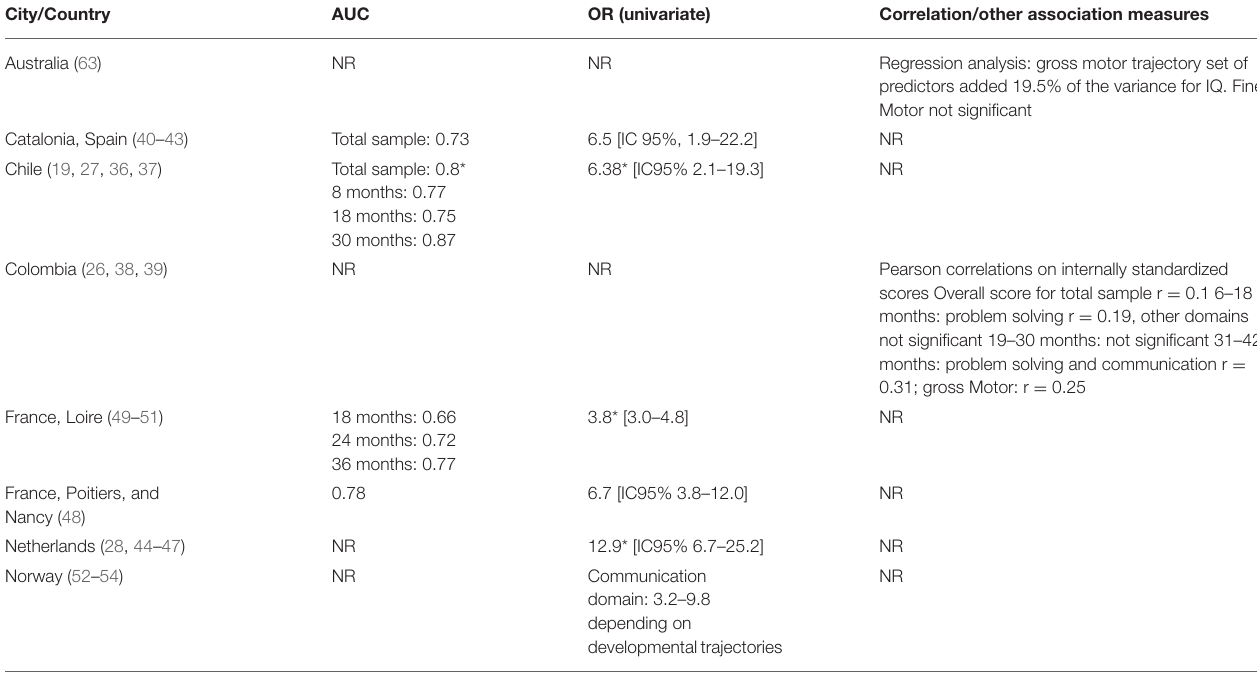
TABLE 2 | Comparison measures and main results of included